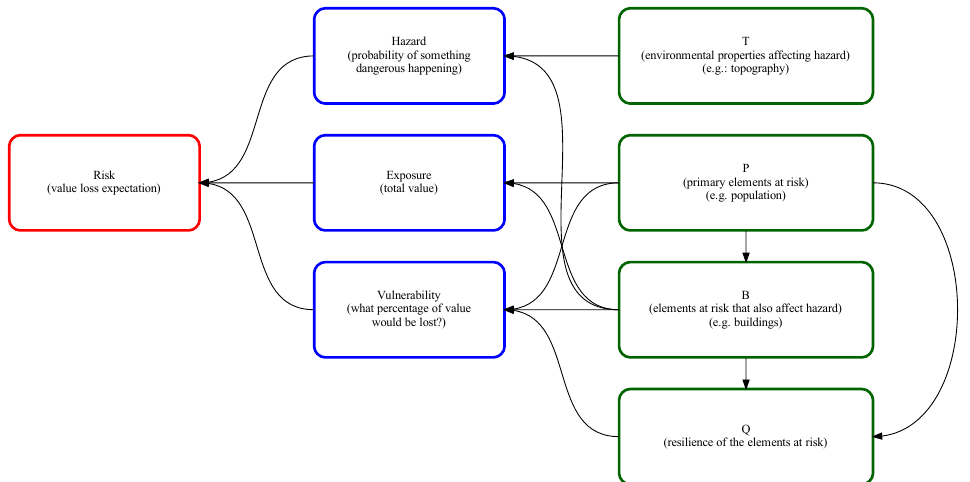
Figure 1. The functional dependencies between risk, vulnerability, exposure, hazard, and their respective input variables. Arrows point towards the dependent (i.e., X → Y indicates that Y depends on X